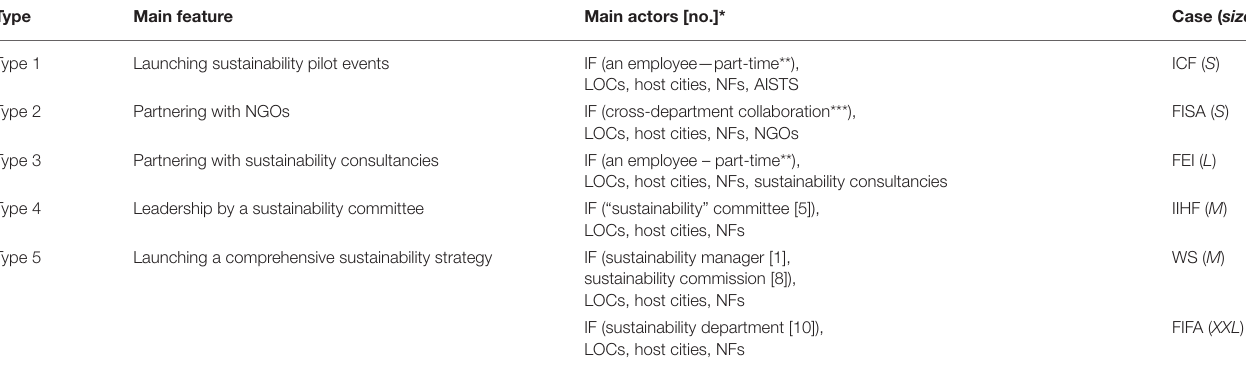
TABLE 3 | Five approaches to